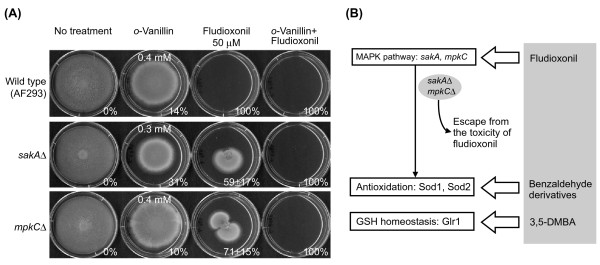
Overcoming fludioxonil tolerance of A. fumigatus MAPK mutants (sakAΔ and mpkCΔ) by chemosensitization. (A) Chemosensitization by using o-vanillin (%: Growth inhibition rate, SD < 5% except where noted). (B) Diagram showing the strategy for efficient control of fungal pathogens by using screened benzaldehyde analogs. 3,5-DMBA, 3,5-Dimethoxybenzaldehyde.